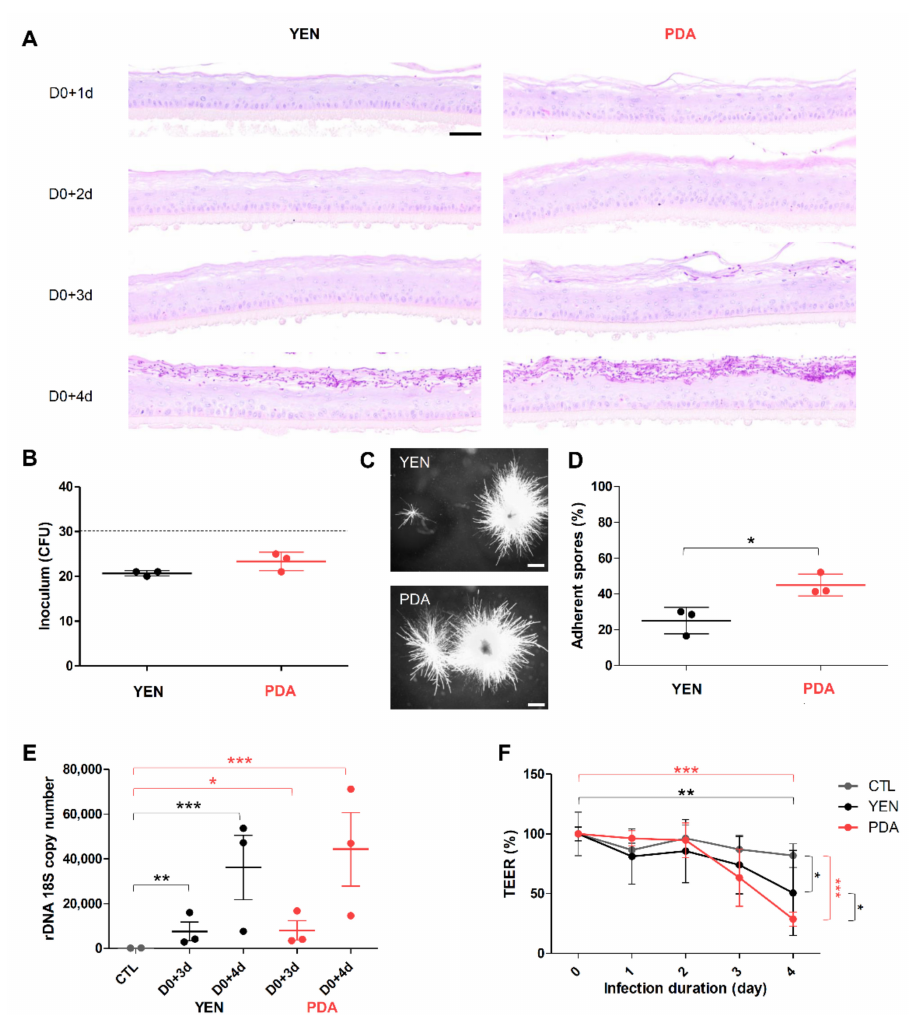
Figure 4. T. benhamiae IHEM 20163 infection on reconstructed human epidermis (RHE). RHE were infected on day zero (D0) by topical addition of inoculum consisting in suspensions of T. benhamiae IHEM 20163 spores recovered after 21 days of incubation over Yeast Extract Nitrogen agar (YEN) at 30 ◦ C under 12% CO 2 , or after 10 days of incubation over Potato Dextrose Agar (PDA) in the same conditions. The inoculum was adjusted to a density of 30 colony-forming units (CFU) per RHE. ( A ) Histological sections were prepared from infected RHE analysed one (D0+1d), two (D0+2d), three (D0+3d) or four (D0+4d) days after infection and then stained using the Periodic-acid Schiff (PAS) procedure with α -amylase pre-treatment and hemalun counterstaining. Scale bar = 50 µ m. ( B ) Fungal load of inoculum was monitored by counting CFU, the dotted line indicates the expected size of inoculum, and ( C ) the macroscopic aspect of CFU was observed. Scale bars = 1 mm. ( D ) Percentage of spores adhering to the epidermis was determined four hours after infection. ( E ) Infection levels were assessed three (D0+3d) and four (D0+4d) days after infection of RHE using qPCR analysis of the rDNA 18S gene copy numbers of T. benhamiae in total DNA extracts prepared from infected RHE (YEN and PDA) or non-infected RHE (CTL). ( F ) Epidermal barrier integrity of RHE during infection was determined by measurements of trans-epithelial electrical resistance (TEER). TEER values are expressed as percentage